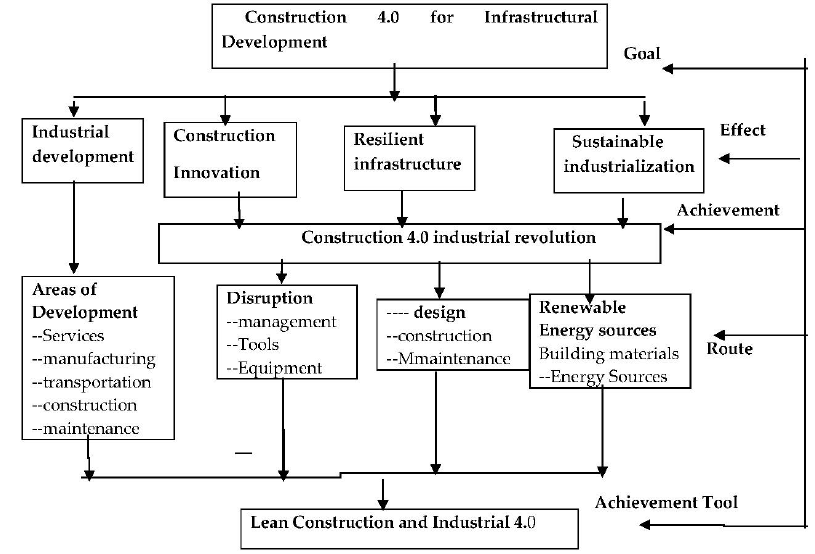
Figure 1. Interrelationship among disruptive innovations, Industry 4.0 and Construction 4.0.